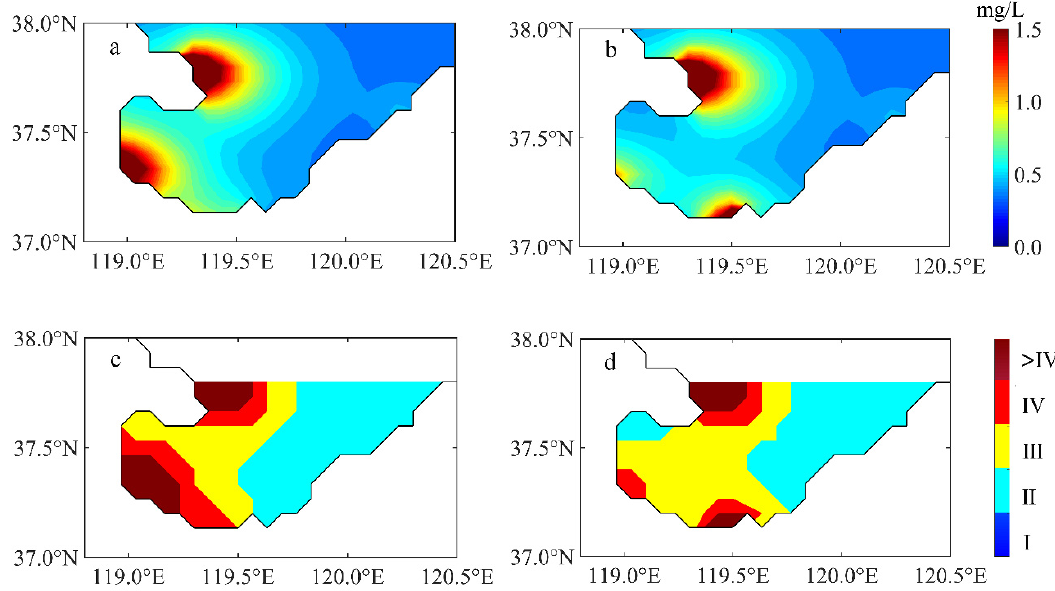
Figure 5. Similar to Figure 3b,c, but for group 18 ( left ) and group 8 ( right ). Then, we compared the area proportions of different seawater qualities in the 20 ex- periments with the control run (Figure 6). There was an obvious variation of the area pro- portion of the seawater that was worse than Grade IV (one quality), where the minimum appeared in group 8, and the maximum appeared in group 11 and group 3. The heavily polluted seawater (two qualities, Grade IV and worse than Grade IV) area proportion changed differently, where the minimum also appeared in group 8, while the maximum value appeared in group 18. In both cases, the allocation adjustment greatly affected the proportions, which gradually declined as the allocation of the Xiaoqinghe River was re- duced. It can be also found that when the total allocation of the Xiaoqinghe River and the Yuhe River accounted for less than 70%, the red line and the orange line dropped to less than 1. When three seawater qualities (including Grade III, Grade IV, and worse than Grade IV) were considered as a whole, the ratio showed slight variation, fluctuating around the value of 1. In particular, the minimum value appeared in group 11, rather than in group 8. Additionally, when three lines were less than 1 at the same time, at least one of the Xiaoqinghe River and the Yuhe River reached the minimum allocation (25% and 6%, respectively). These results confirm the ranking of the three rivers in terms of influ- ence on the seawater quality: the Xiaoqinghe River > the Yuhe River > the Jiaolaihe River.